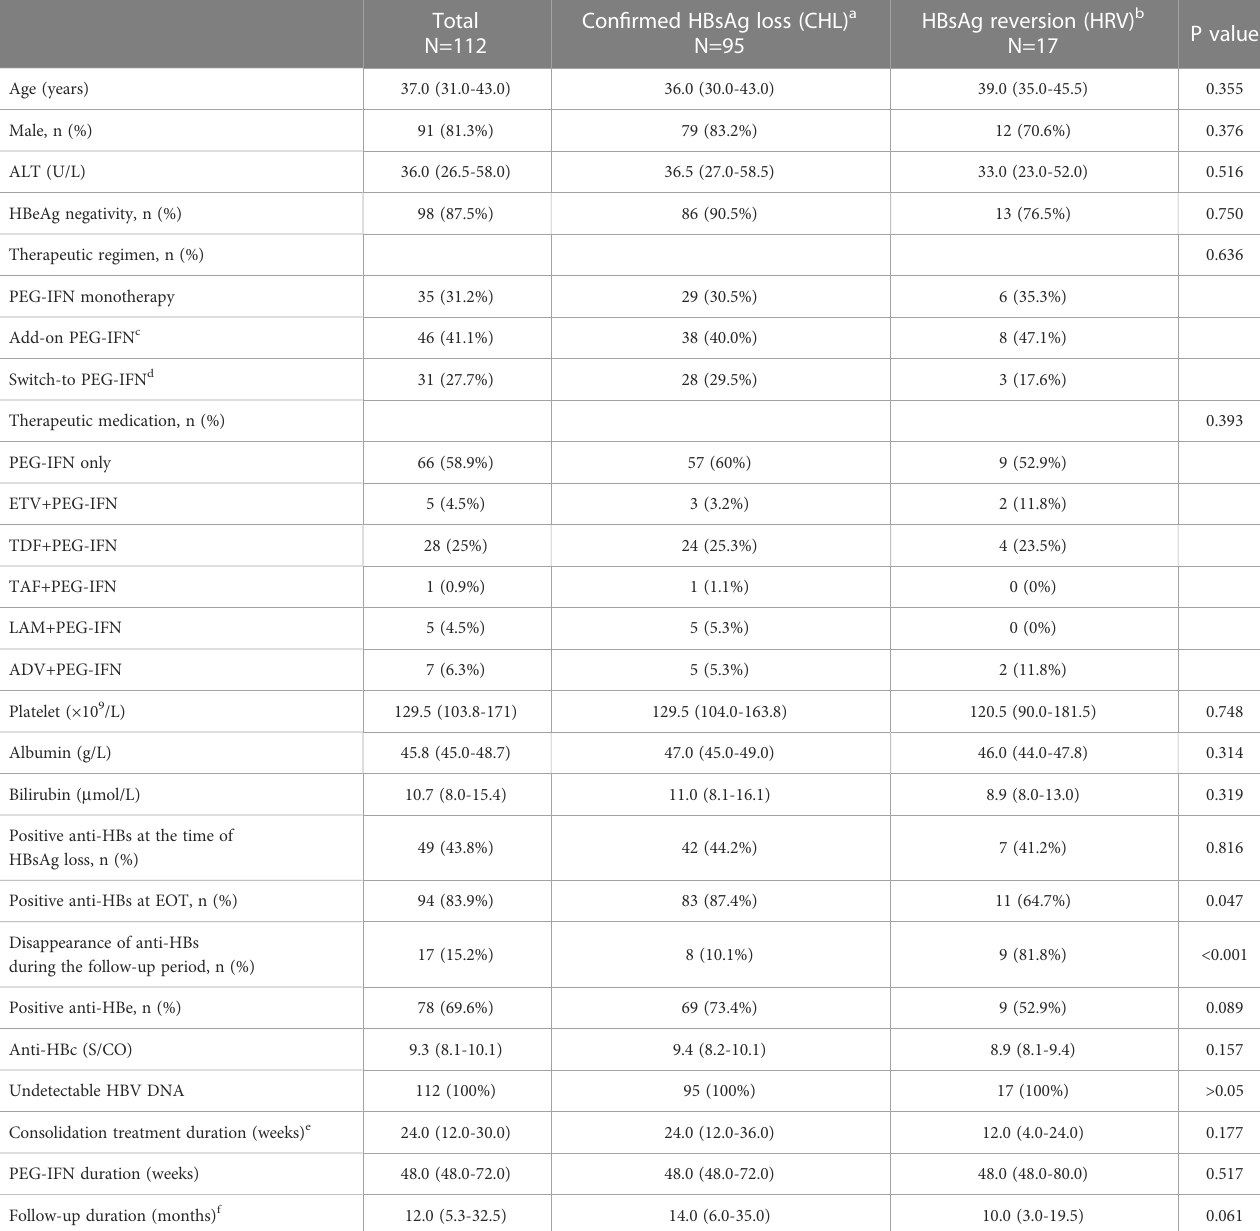
TABLE 2 Clinical characteristics of 112 CHB patients with HBsAg loss during and post PEG-IFN